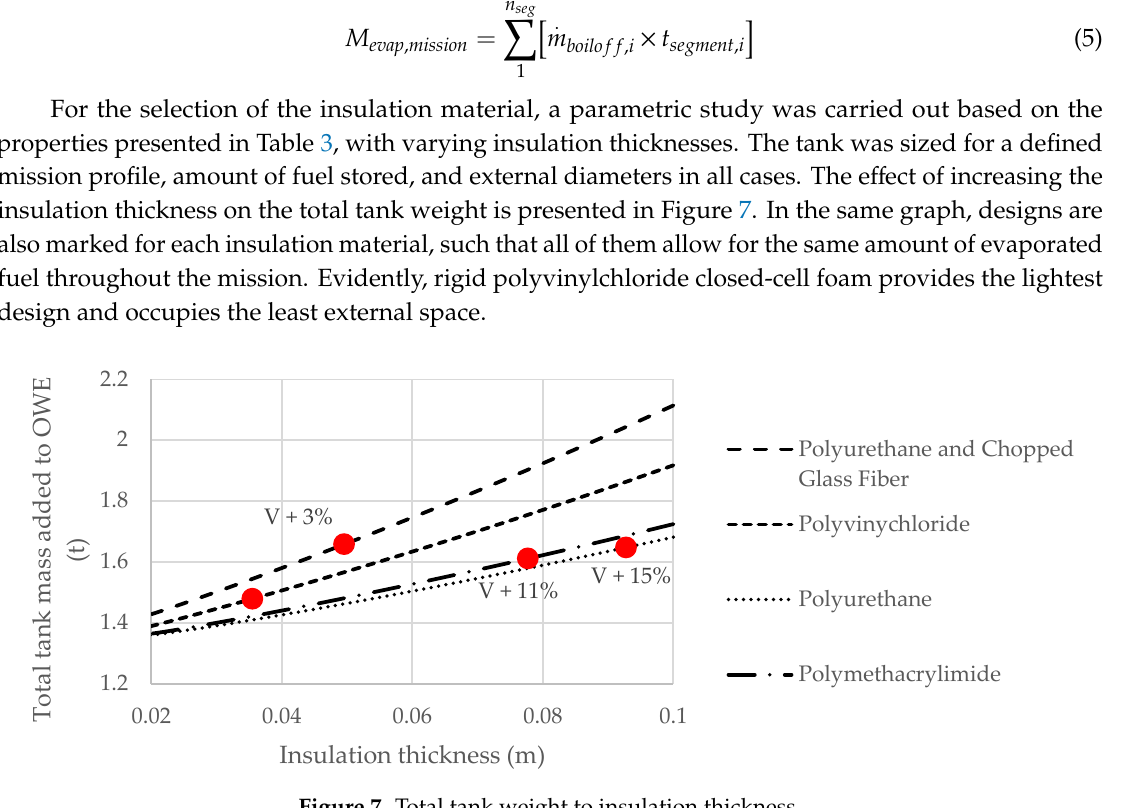
Figure 7. Total tank weight to insulation thickness.